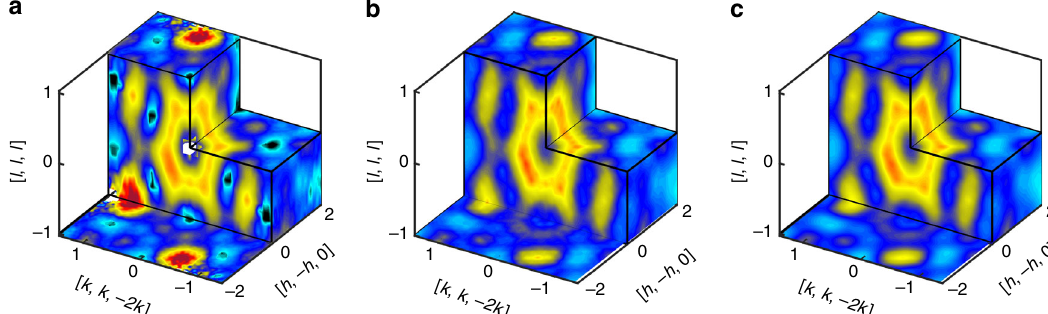
Fig. 2 Comparison of the experimental and simulated data. a The scattering function S exp ( Q ) for the Dy 2 Ti 2 O 7 crystal at 680 mK. b The same experimental data after being fi ltered by the autoencoder, S exp Q Þ . c Simulated scattering data from the optimal model spin Hamiltonian, S sim AE ð from ( a ) to ( b ), the autoencoder has fi ltered out experimental artifacts such as the red peaks, the missing data at the dark patches, etc. Using both scattering and heat capacity data, we determine the optimal spin Hamiltonian couplings to be J 2 = 0.00(6) K, J 3 = 0.014 (16) K and J 3 0 = 0.096(12) K with = 3.41 K and D = 1.3224 K having been fi xed in prior work J 1